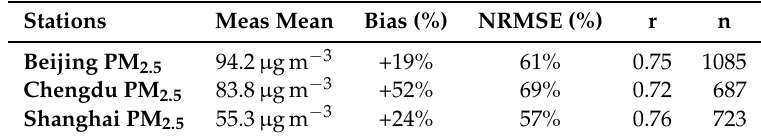
Table 4. CHIMERE model PM 2.5 comparison to daily measurements from monitoring stations for 2011, 2013 and 2015. n indicates number of daily mean measurements.